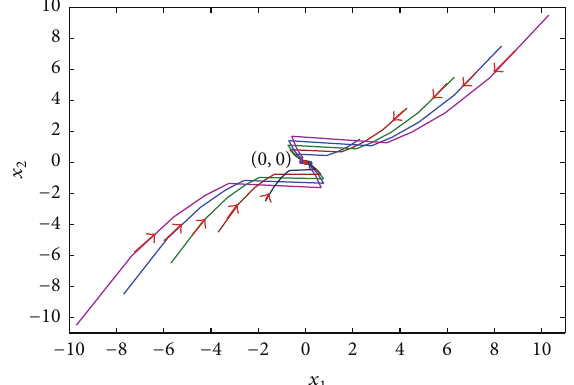
Figure 4: Time response of the state variables 𝑥 1 (𝑡) and 𝑥 2 (𝑡) with different initial